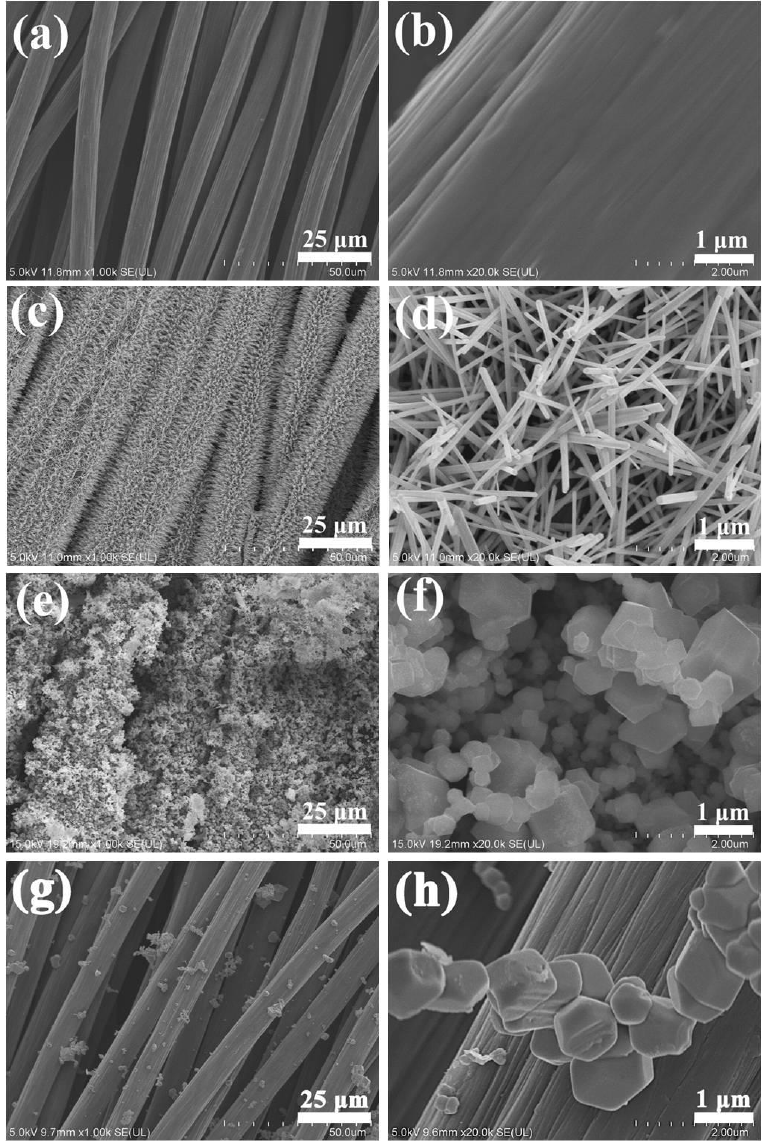
Figure 3. SEM images of CC ( a , b ), CC/ZnO ( c , d ), CC/ZnO@Ag 3 PO 4 ( e , f ), and CC/Ag 3 PO 4 ( g , h ).